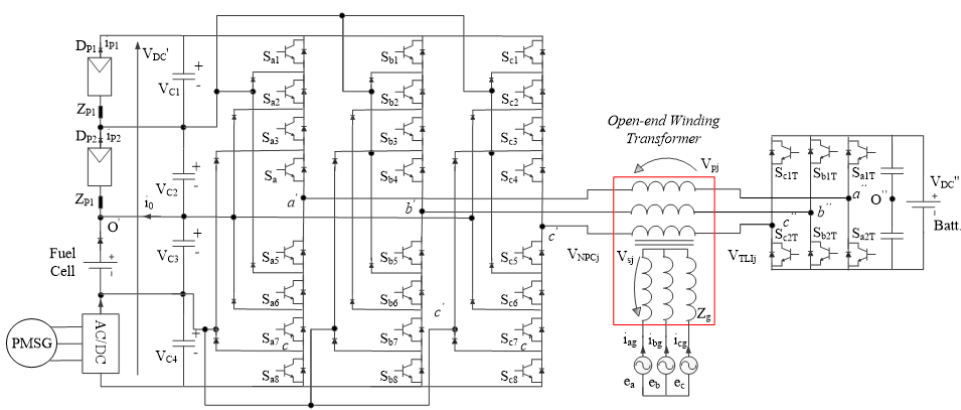
Figure 3. Ten-level MMC (5LI + TLI) with four energy sources and an energy storage